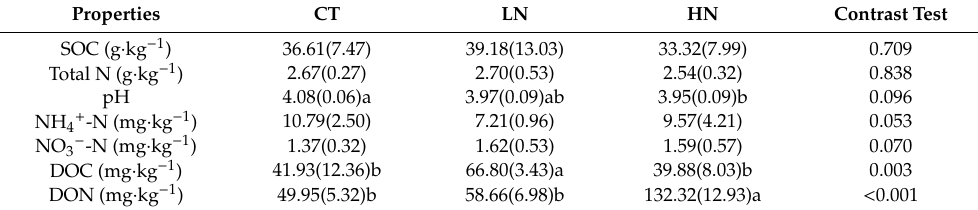
Table 1. E ff ects of N deposition on soil physicochemical properties.